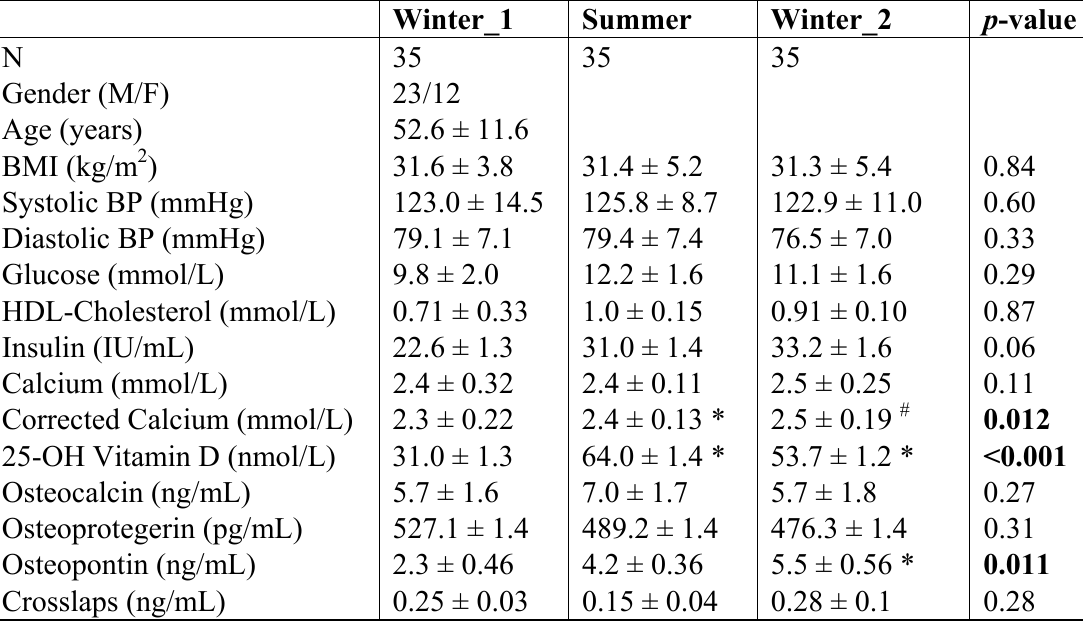
Table 2. Effect of Season and Vitamin D on Bone Markers.